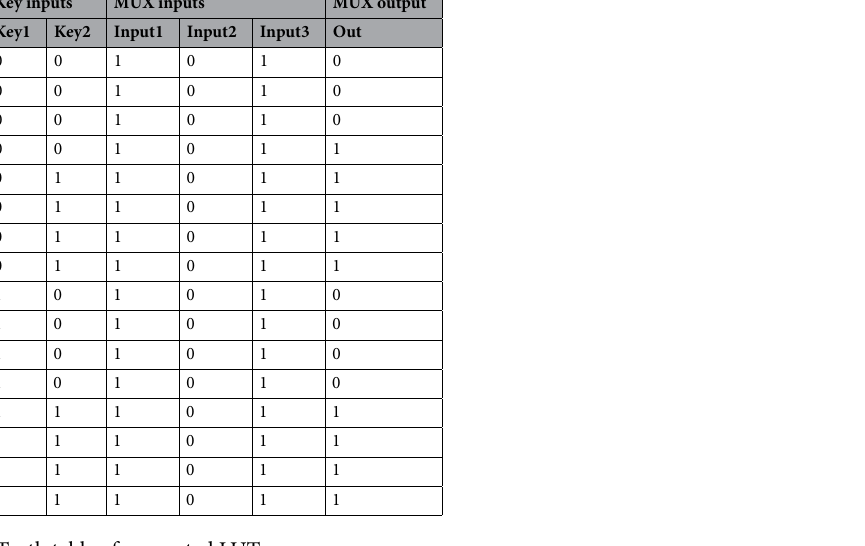
Table 3. Truth table of encrypted